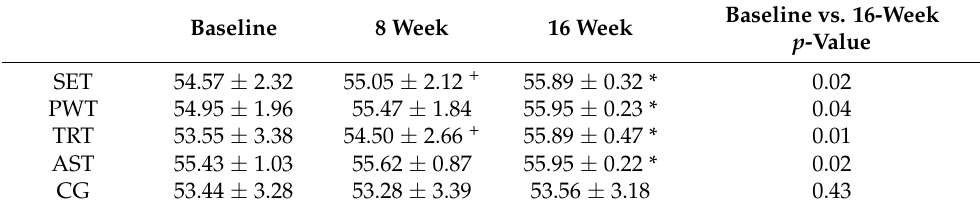
Table 2. Berg Balance